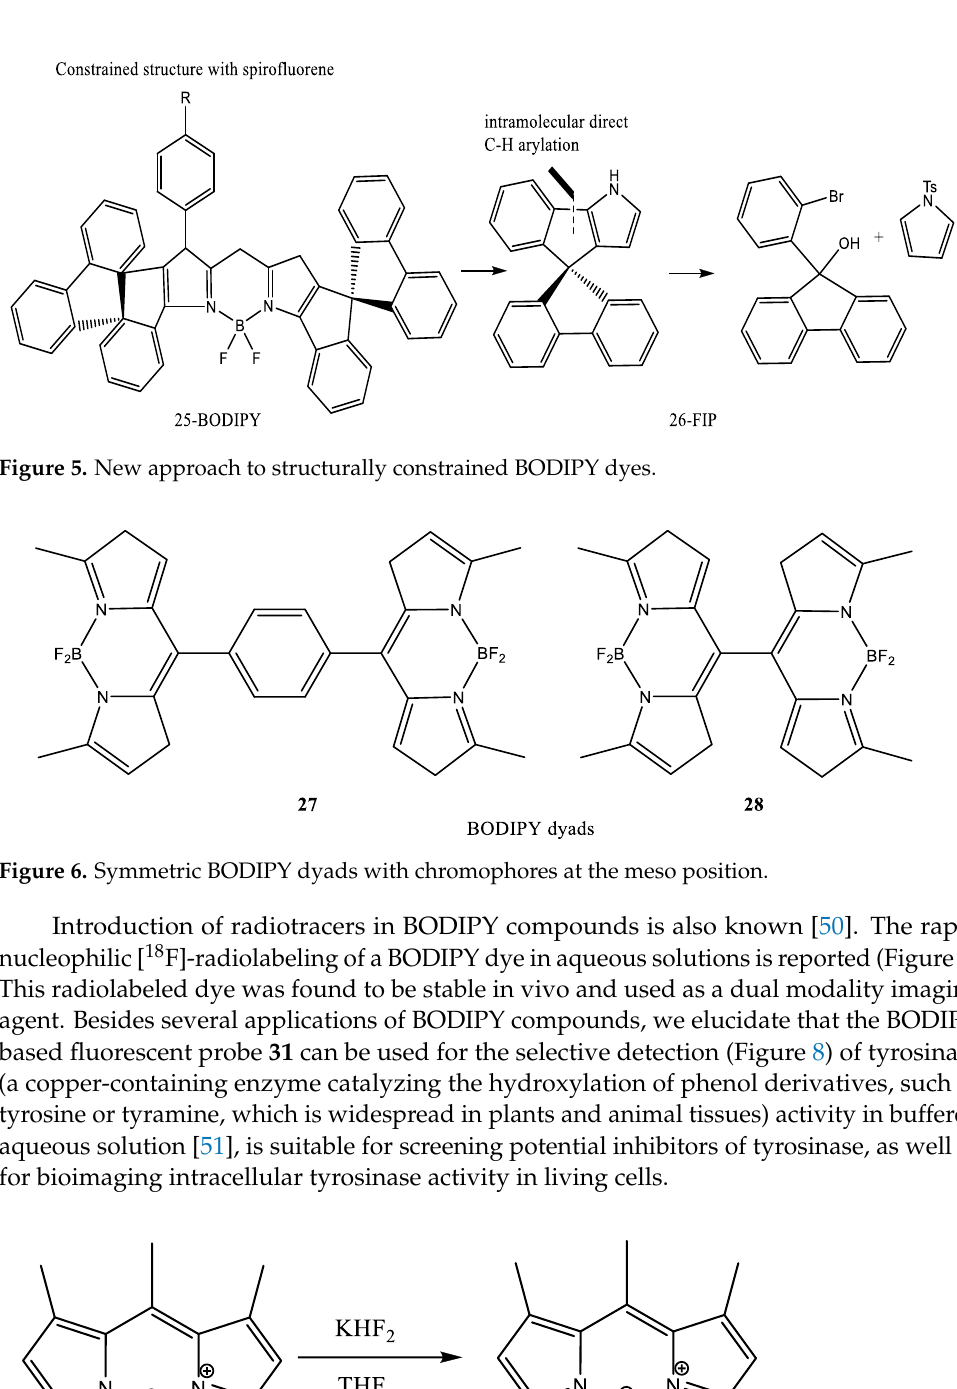
Figure 8. Proposed fluorescence turn-on assay for tyrosinase by probe 31 . Some NBN-environment-based organoboron compounds have also been reported with a wide variety of applications. Thus, optically active organoboron aminoquino- late-based coordination polymers bearing the chiral side chain derived from L-alanine were synthesized (Scheme 6) and their optical behavior was studied by UV – Vis and photoluminescence spectroscopies [52]. The hydrogen-bonding in these polymers was found to be stable in solvents such as CHCl 3 and DMF studies of circular dichroism (CD). Intramolecular charge transfer was observed due to the fact of solvents polarity. Further, some toxic compounds such as Triphenyl borane were studied (Figure 9). The toxicity of the alternative organotin (Ot) antifoulants TPBP (triphenylborane pyridine; Figure 9: 34) and TPBOA (triphenylborane octadecylamine; Figure 9: 35) and their degradation prod- ucts on Crassosteagigas and Hemicentrotuspulcherrimus were tested [53]. Silylat- ed-diborylene-3,4,9,10-tetraaminoperylenes (DIBOTAPs, compounds 39 – 42 ) were syn- thesized by treating 4,9-diaminoperylenequinone-3,10-diimine (DPDI, Scheme 7) with BH 3 – THF, lithiation with n -butyllithium, and subsequent addition of the corresponding silyl chloride (Scheme 8) [54]. In all cases, the perylene backbones were found to be not completely planar. The coordination of the nitrogen donor atoms to the Lewis acidic boron atoms stabilizes the tetraaminoperylene core, while the N -silylation appears to suppress aggregation in solution. The latter enables the high luminescence quantum yields. The exchange of all three methyl groups with ethyl (compound 39 ) or isopropyl (compound 40 ) substituents resulted in a significant increase in quantum yields with values of 92% and 89%, respectively. The observed fluorescence decay is monoexponen- tial for all dyes with typical lifetimes of 5.5 – 6.6 ns.